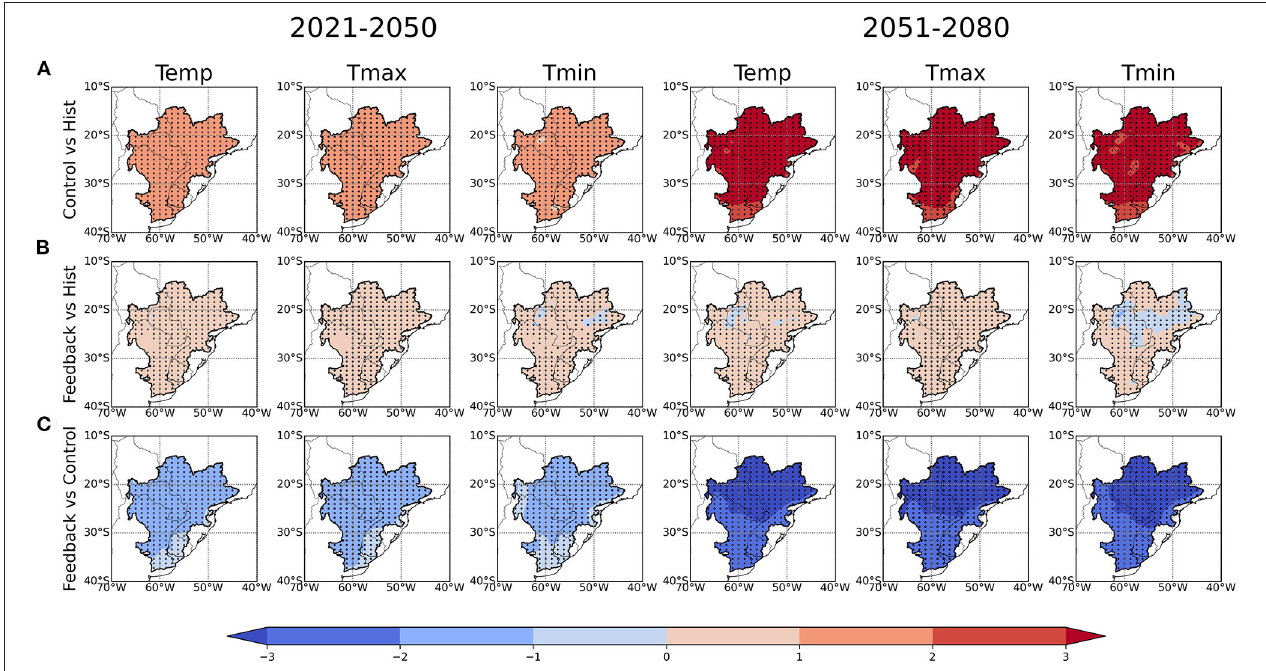
FIGURE 2 | Annual projected changes in mean, maximum, and minimum temperature ( ◦ C) derived from the three-member ensemble mean values for two future 30-year periods (2021–2050 and 2051–2080) and the mean values over the historical period (1980–2010): (A) Projected changes under the RCP8.5 emission scenario (control simulations) relative to historical, (B) projected changes for the geoengineering simulations combined with the RCP8.5 pathway (feedback simulations) relative to historical, and (C) the difference between (A,B) . Stippling indicates robust changes according to the definition of robustness adopted in this study [see section projections in the text for further